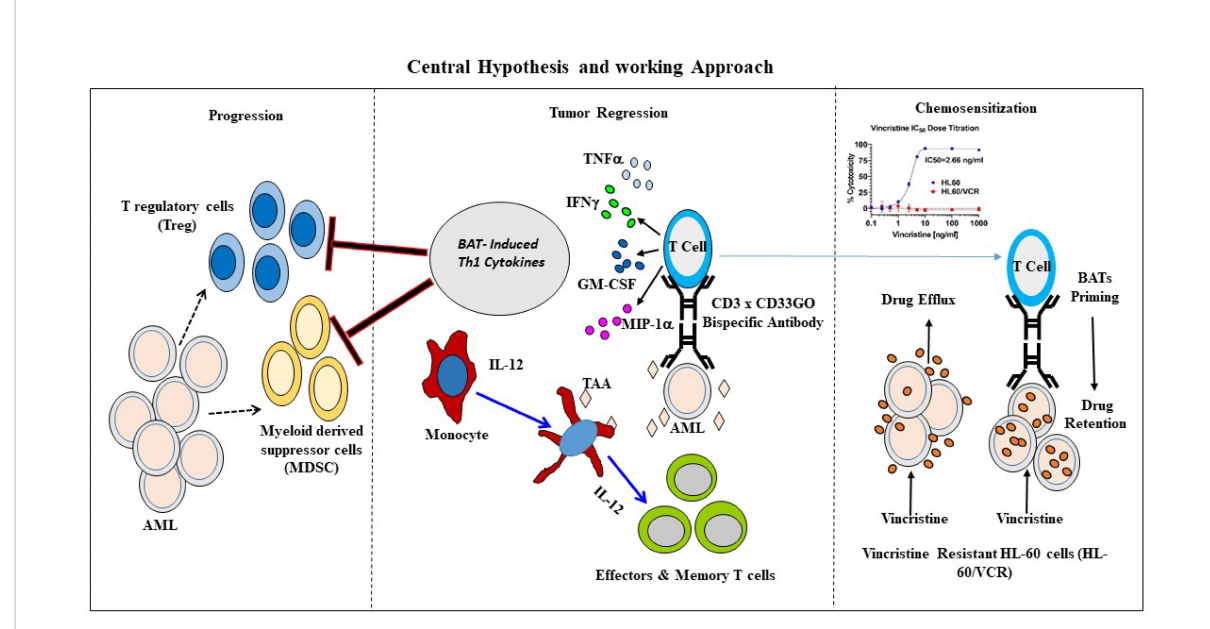
FIGURE 7 Schematic representation of BATs mediated antitumor effects. Middle panel shows an overview of immunotherapy approach to re-direct T cells using bispeci fi c antibody. Arming of polyclonally activated T cells (ATC) with bispeci fi c antibody combines the targeting speci fi city of mAbs and non-MHC-restricted cytotoxicity of T cells. BATs engagement to tumor cells kills target cells releasing tumor antigens as well as cytokines/ chemokines in the TME. Chemokines recruits endogenous immune cells in the TME. Cytokines GM-CSF and TNF-a stimulates monocytes for activation and maturation into antigen presenting cells (APC) with eventual antigen presentation by APC to naïve T cells, which leads to the clonal expansion of tumor-speci fi c effectors and central memory cells differentiation, and development of long-term anti-tumor immunity. Left panel showing that Th1 cytokine enriched microenvironment inhibits immune suppressor cells such as T regulatory cells (Tregs) and myeloid derived suppressor cells (MDSC) thus enhancing anti-tumor activity by BATs. Right Panel shows that priming of the vincristine resistant AML cells (HL-60/VCR) with BATs can “ sensitize ” drug resistant cells for effective killing by chemotherapy drug by downregulating expression of MDR related proteins responsible for chemo drug ef fl